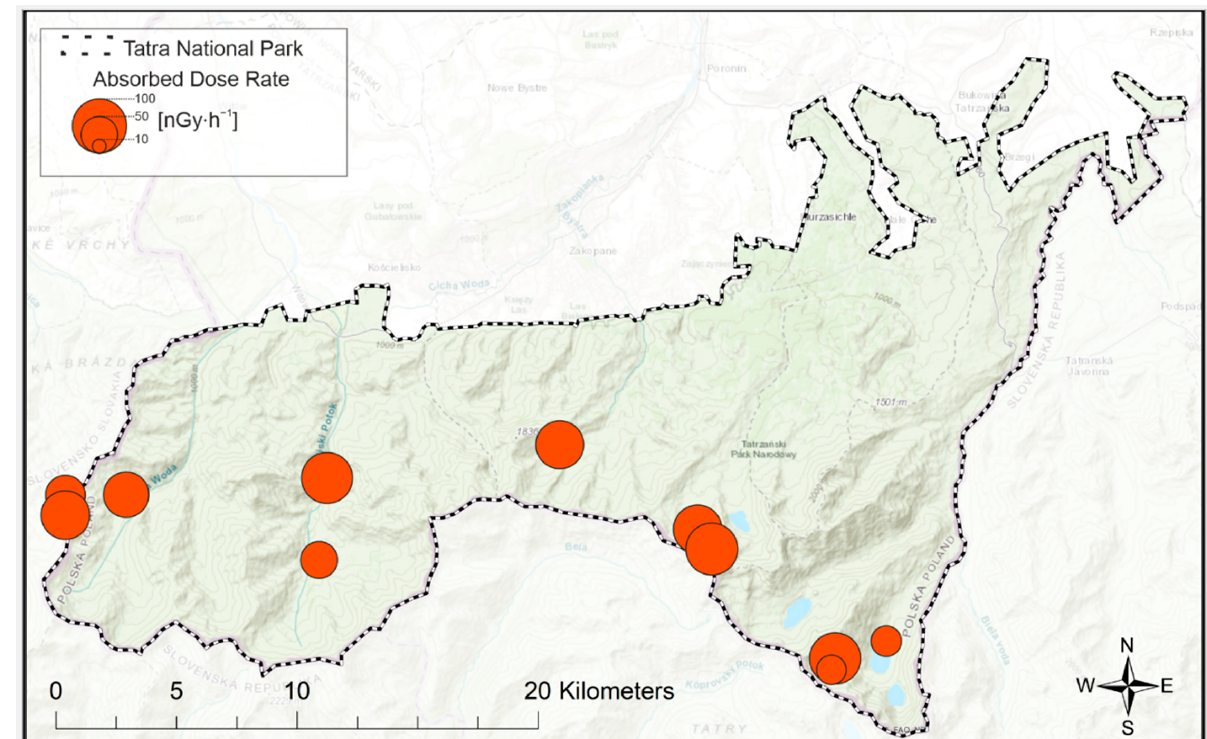
Figure 8. The spatial distribution of ADR in the area of the Tatra National Park.